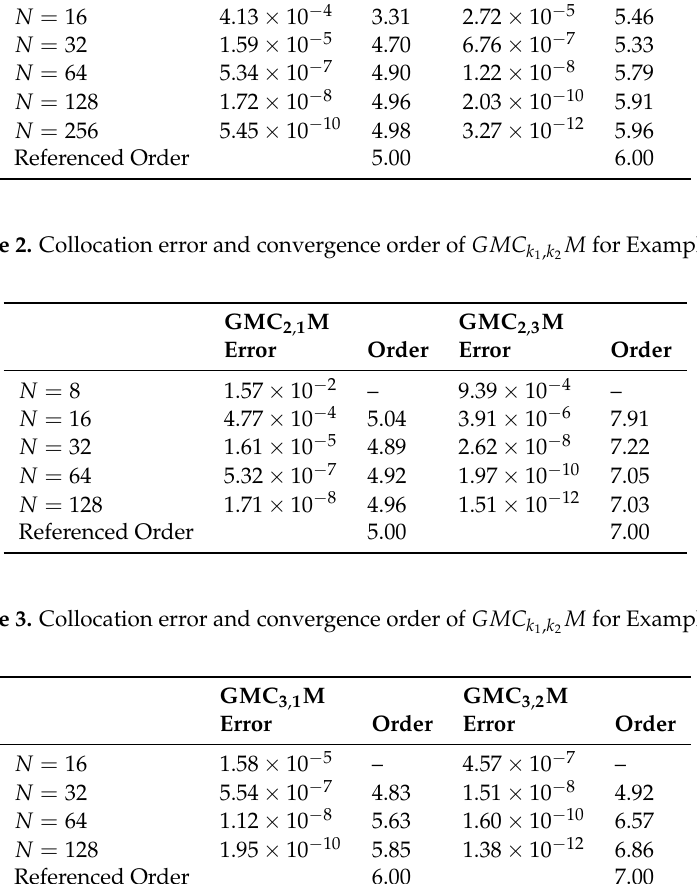
Table 1. Collocation error and convergence order of GMC k